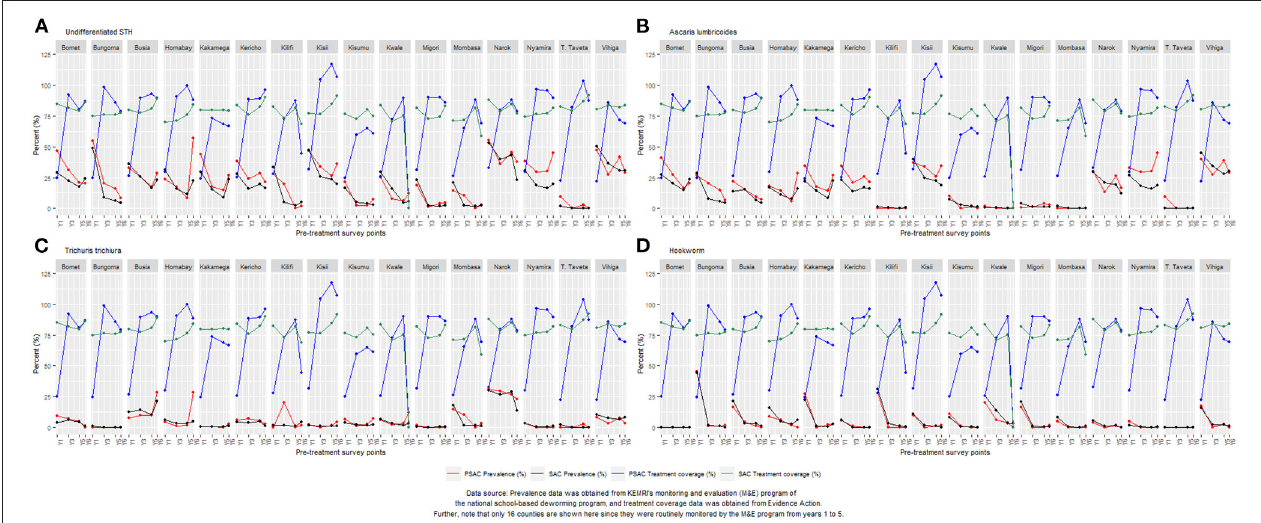
FIGURE 2 | County-level trend of STH infections prevalence and treatment coverage for year 1 (Y1), year 3 (Y3), year 5 (Y5), and year 6 (Y6) survey time points among preschool PSAC) and school (SAC) aged group of children in Kenya. The overlay of undifferentiated STH prevalence with treatment coverage is shown in (A) , Ascaris lumbricoides (B) , Trichuris trichiura (C) , and hookworm (D) .